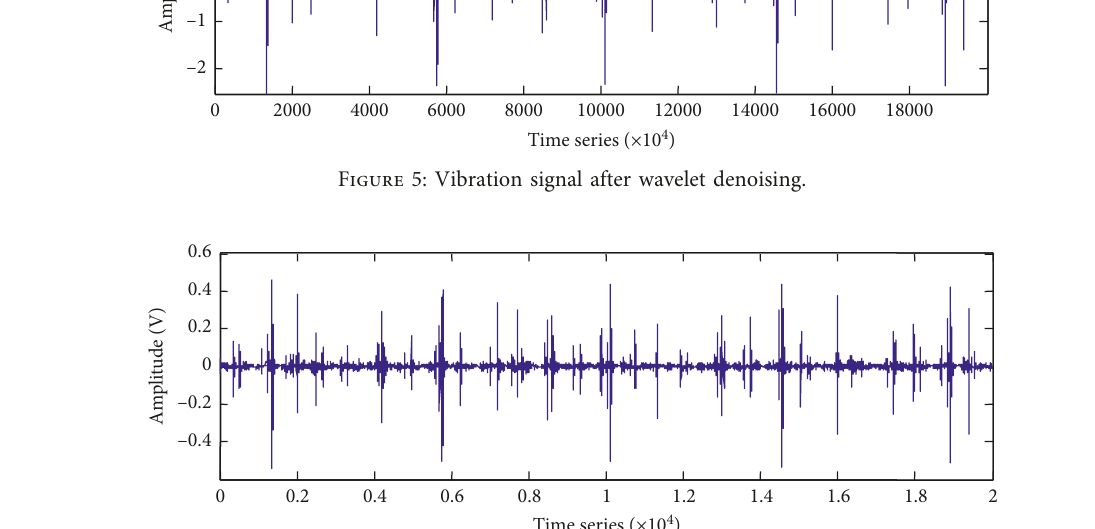
Figure 6: Noise-free vibration signal after standardized processing.